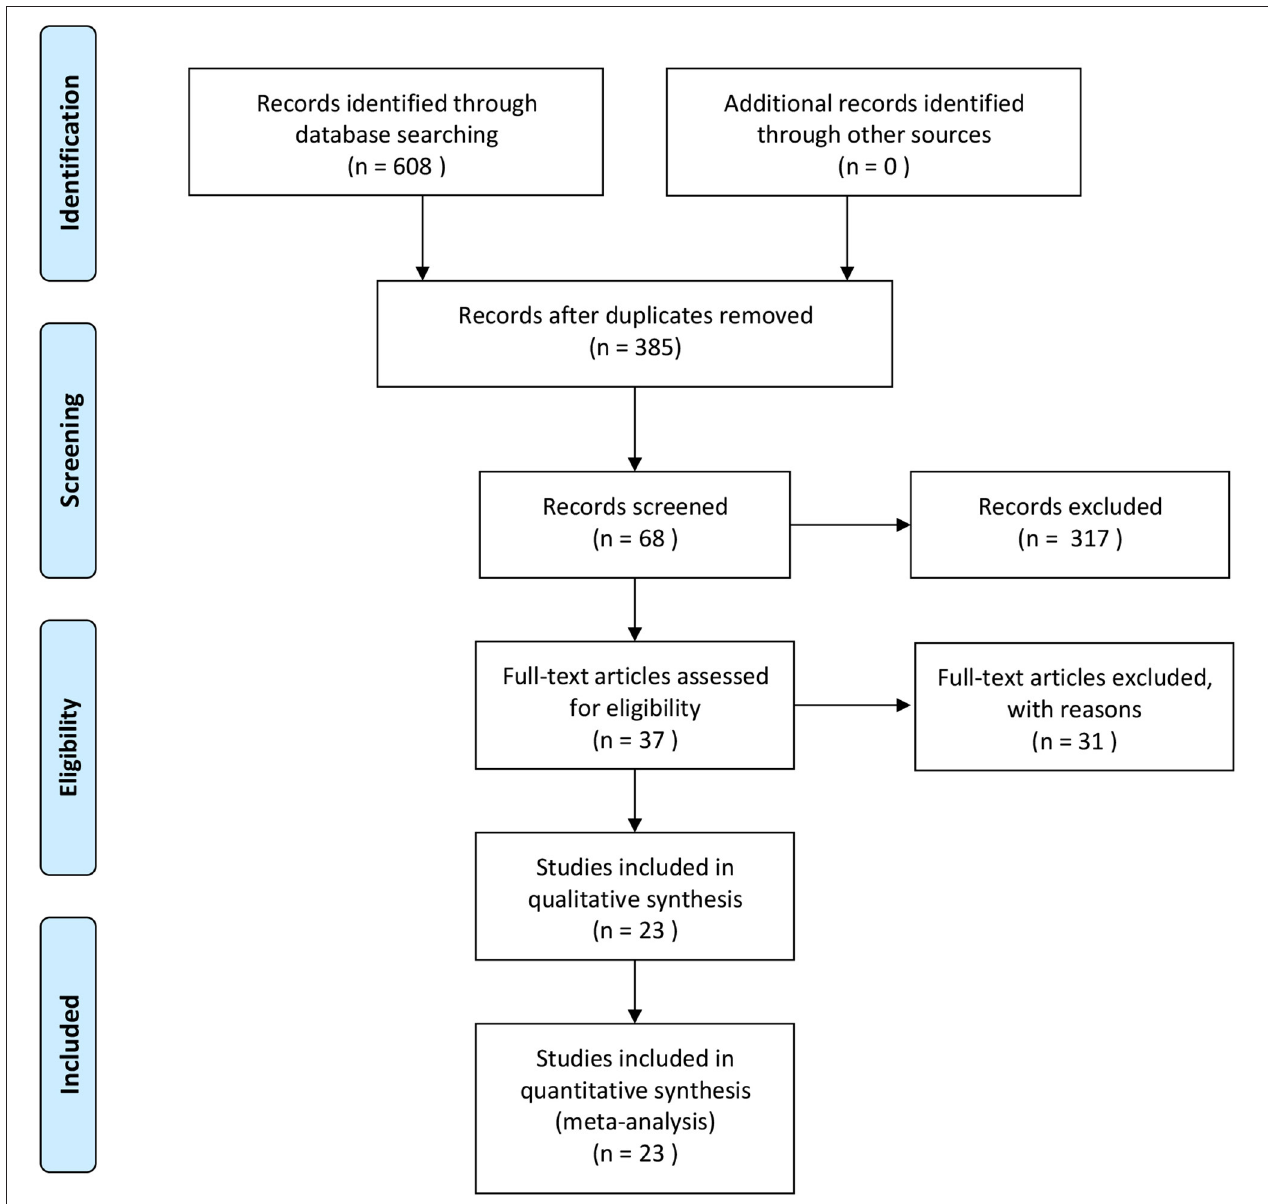
FIGURE 1 | Study screening flowchart. PRISMA, preferred reporting items for systematic reviews and